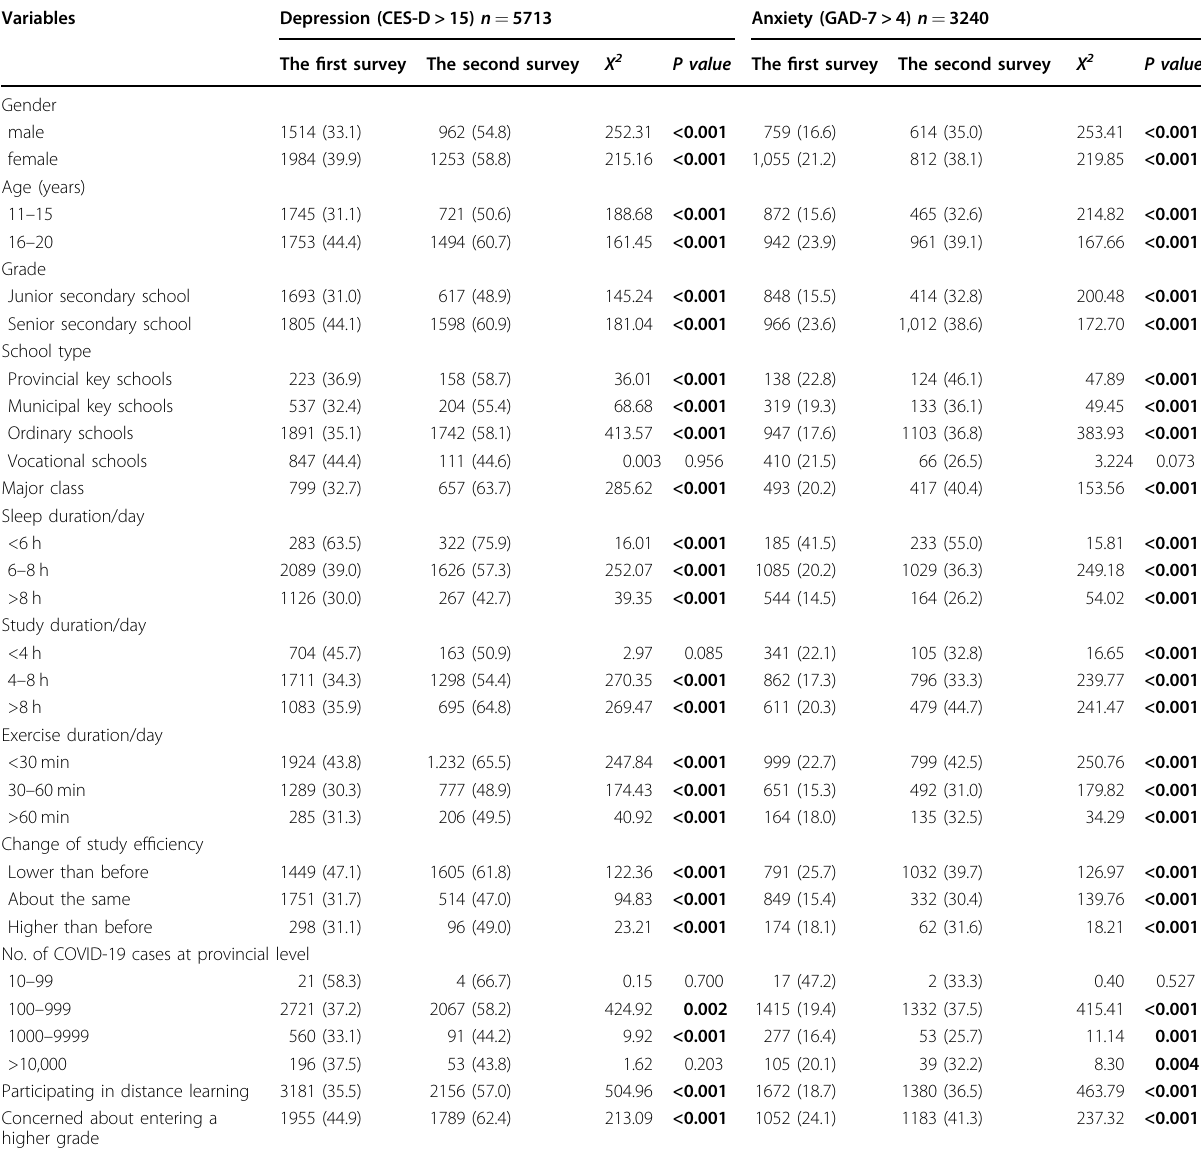
Table 2 The comparison of the prevalence of depression and anxiety between the fi rst and second surveys.